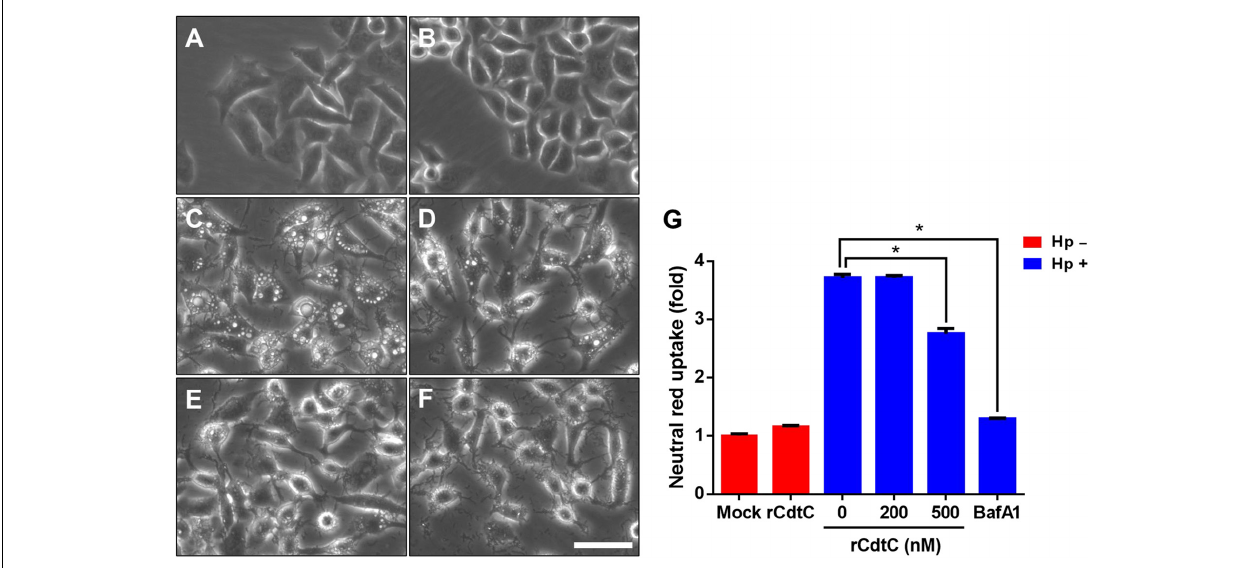
FIGURE 1 | rCdtC inhibits Helicobacter pylori -induced vacuolation in gastric epithelial cells. AGS cells were (A) untreated with rCdtC, (B) treated with 200 nM rCdtC alone, (C) infected with H. pylori for 6 h, (D) pretreated with 200 nM rCdtC prior to H. pylori infection for 6 h, (E) pretreated with 500 nM rCdtC followed by H. pylori infection for 6 h, and (F) pretreated with 0.1 µ M BafA1 then infected with H. pylori for 6 h. Cell vacuolation was observed by using a phase-contrast microscope. Scale bar, 100 µ m. (G) Neutral red uptake assay was employed to analyze the vacuolating activity. Each group was performed in three independent experiments (* P <